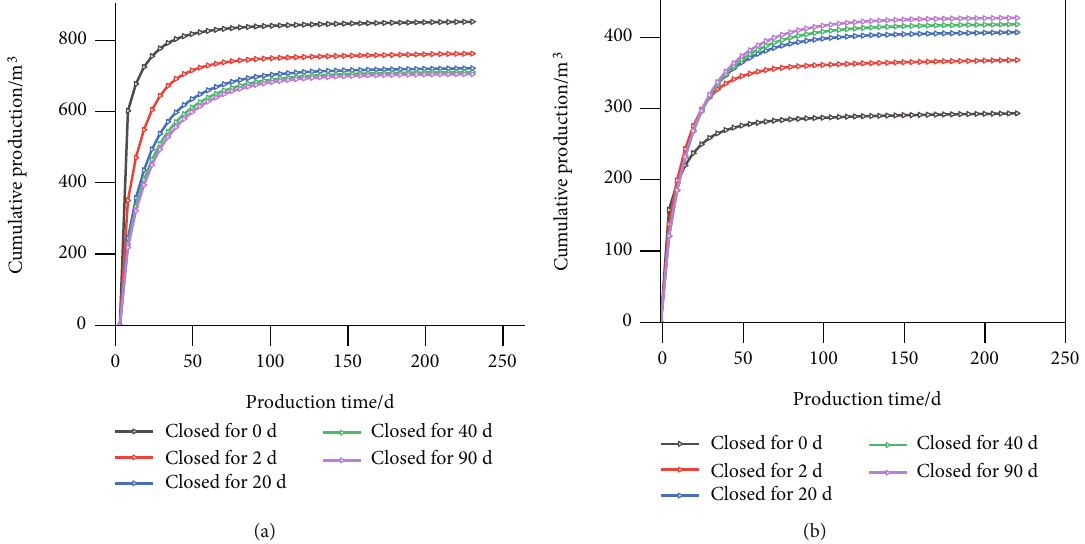
Figure 11: Comparison of cumulative production after di ff erent shut-in times: (a) cumulative water production and (b) cumulative oil production.